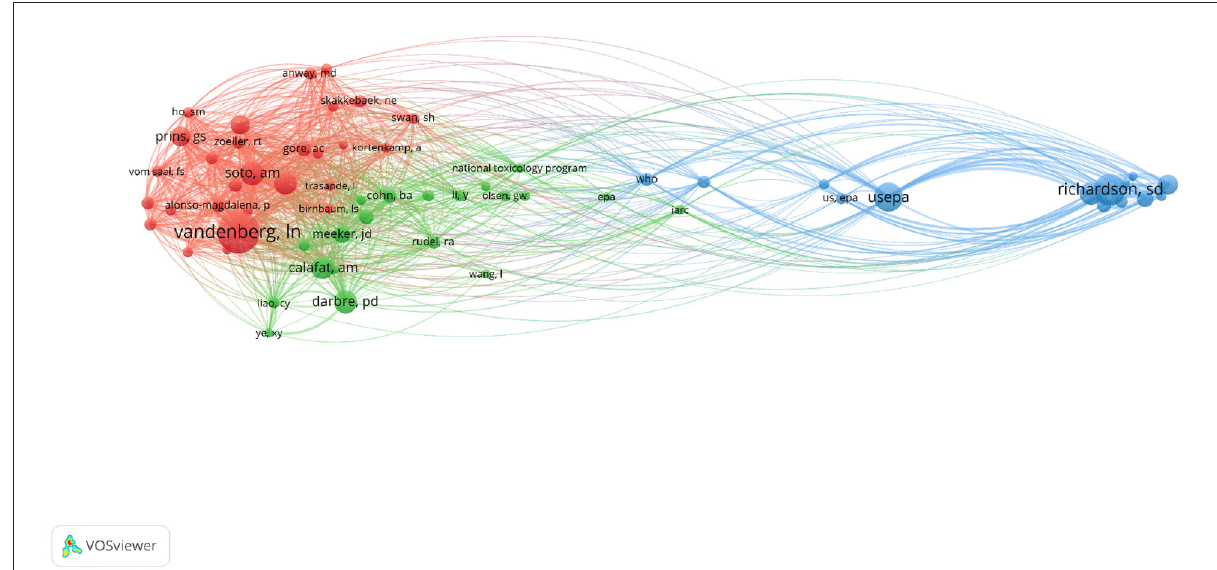
FIGURE7 The network visualization map of co-citations between authors with 100 or more than 100